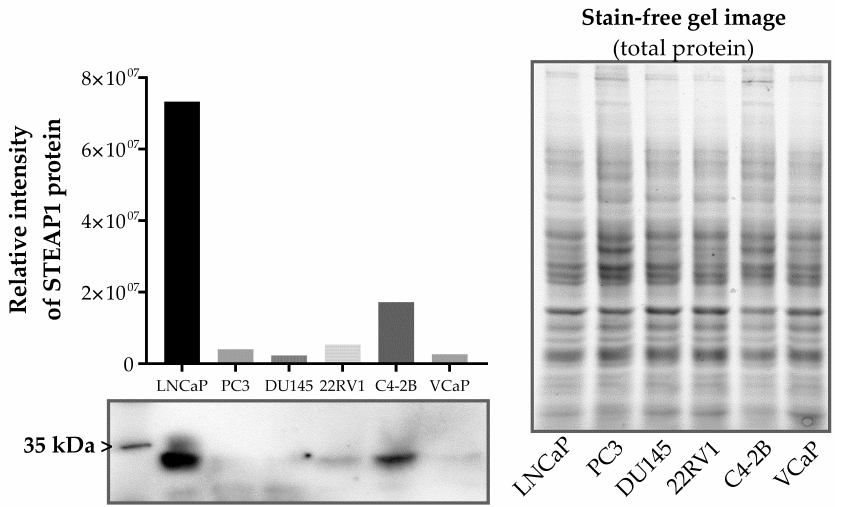
Figure 1. Comparison of STEAP1 expression levels in different PCa cell lines. Relative immunoreac- tivity of STEAP1 in PCa cell lines (LNCaP, PC3, DU145, 22RV1, C4-2B and VCaP) by Western